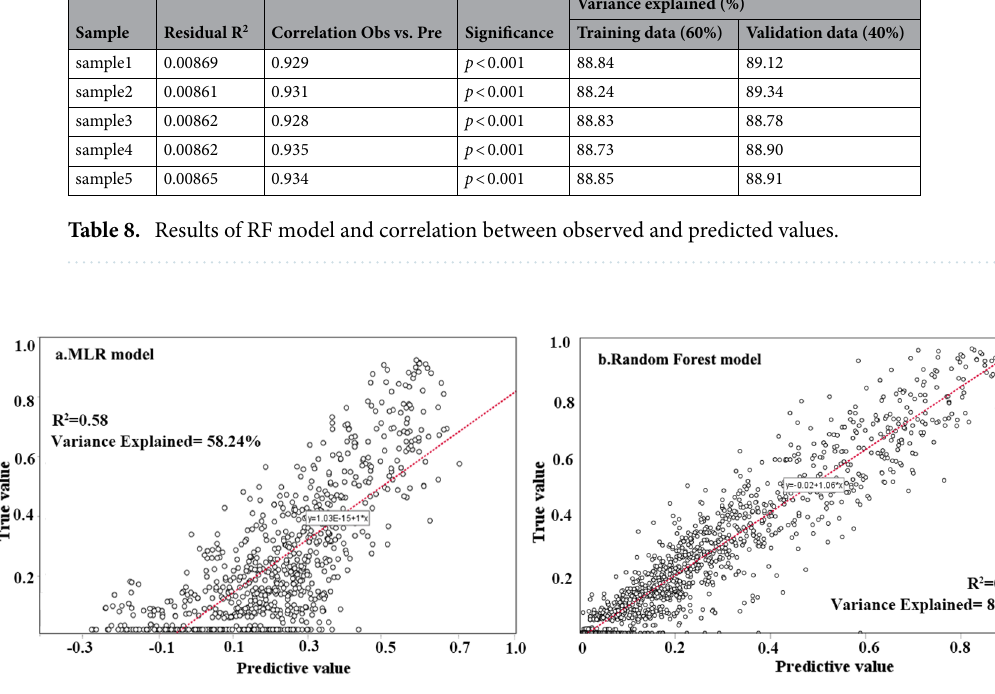
Figure 6. Observed and predicted values by MLR and RF